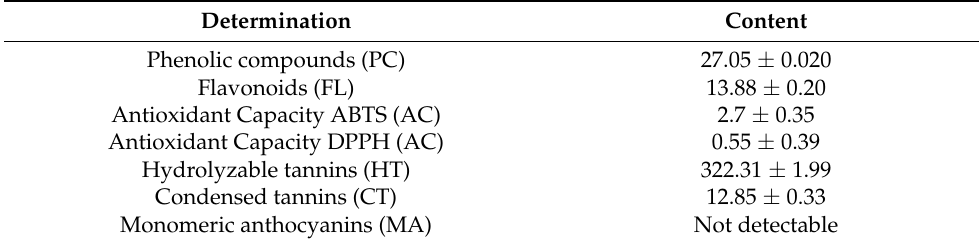
Table 1. Bioactive compounds in dried muicle leaves using optimal extraction